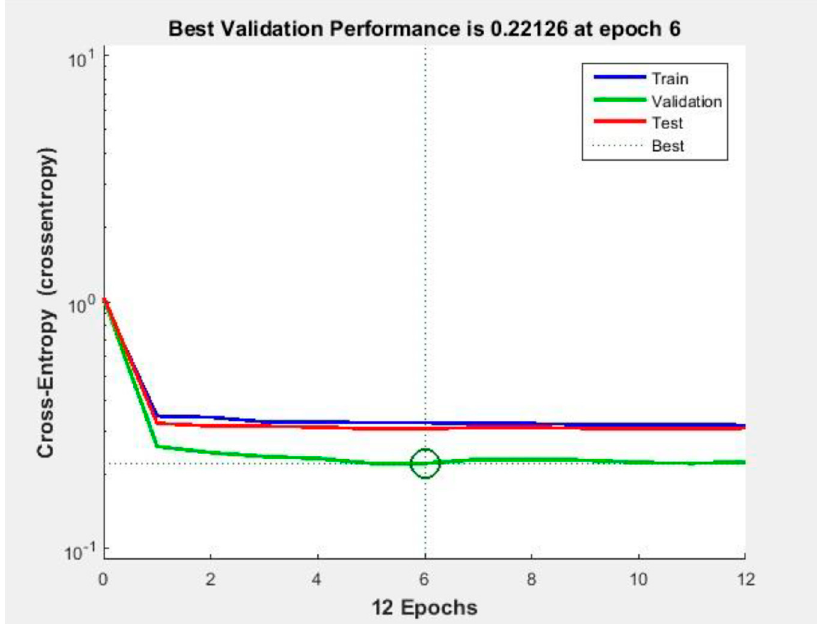
Figure 12. Characteristics of error changes during the learning process of a network using third-degree polynomial coefficients.